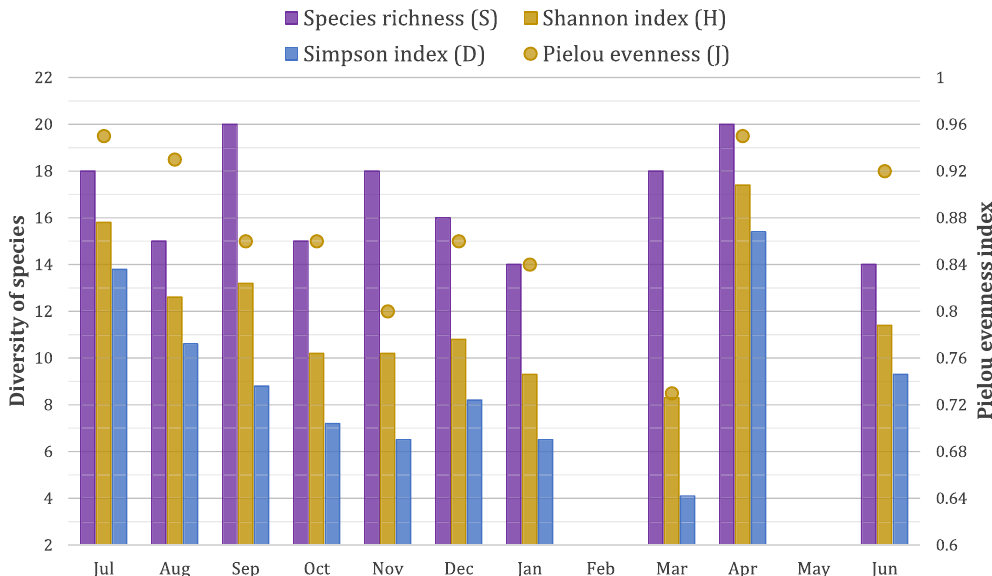
Figure 2. Monthly observed bird diversity indices on duck foraging areas.